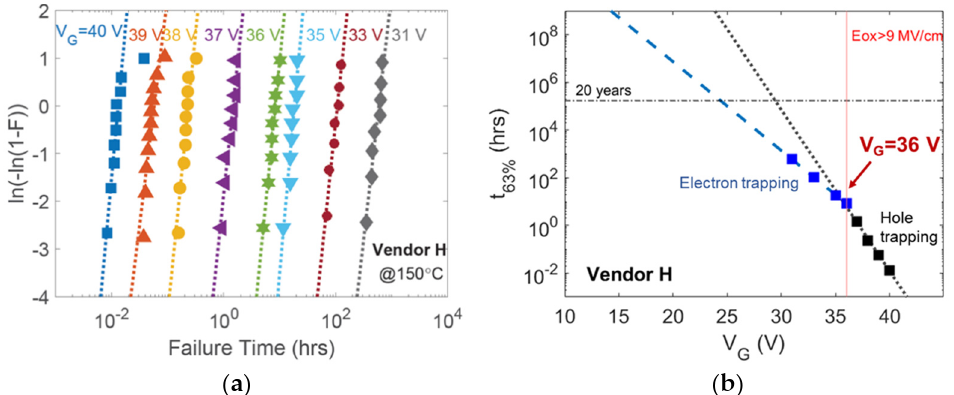
Figure 14. ( a ) Weibull distribution at 150 °C with different gate biases; ( b ) predicted failure times [17].